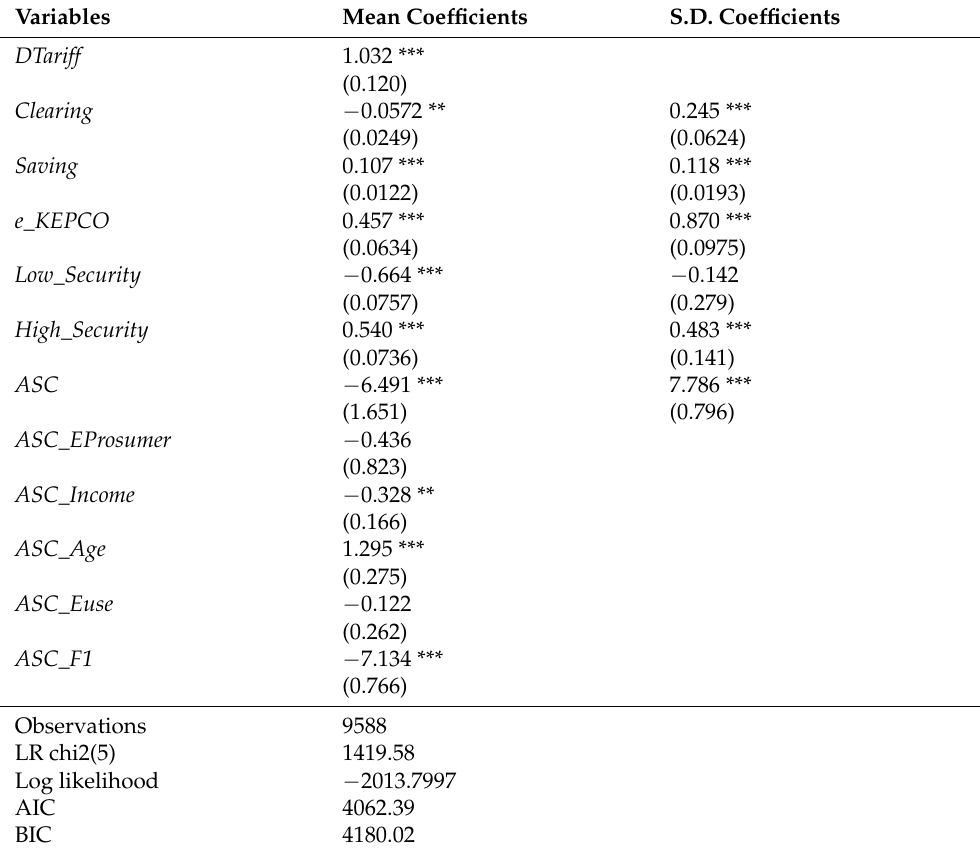
Table 3. Mixed Logit Model Estimation.